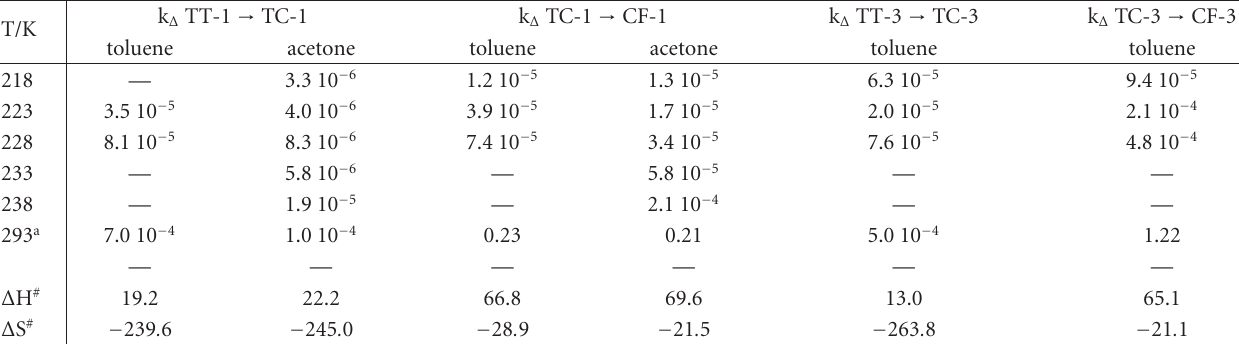
Table 1: Kinetic rate constants (k Δ in s − 1 ) and thermodynamic parameters (enthalpy variation Δ H # in kJ · mol − 1 and entropy variation Δ S